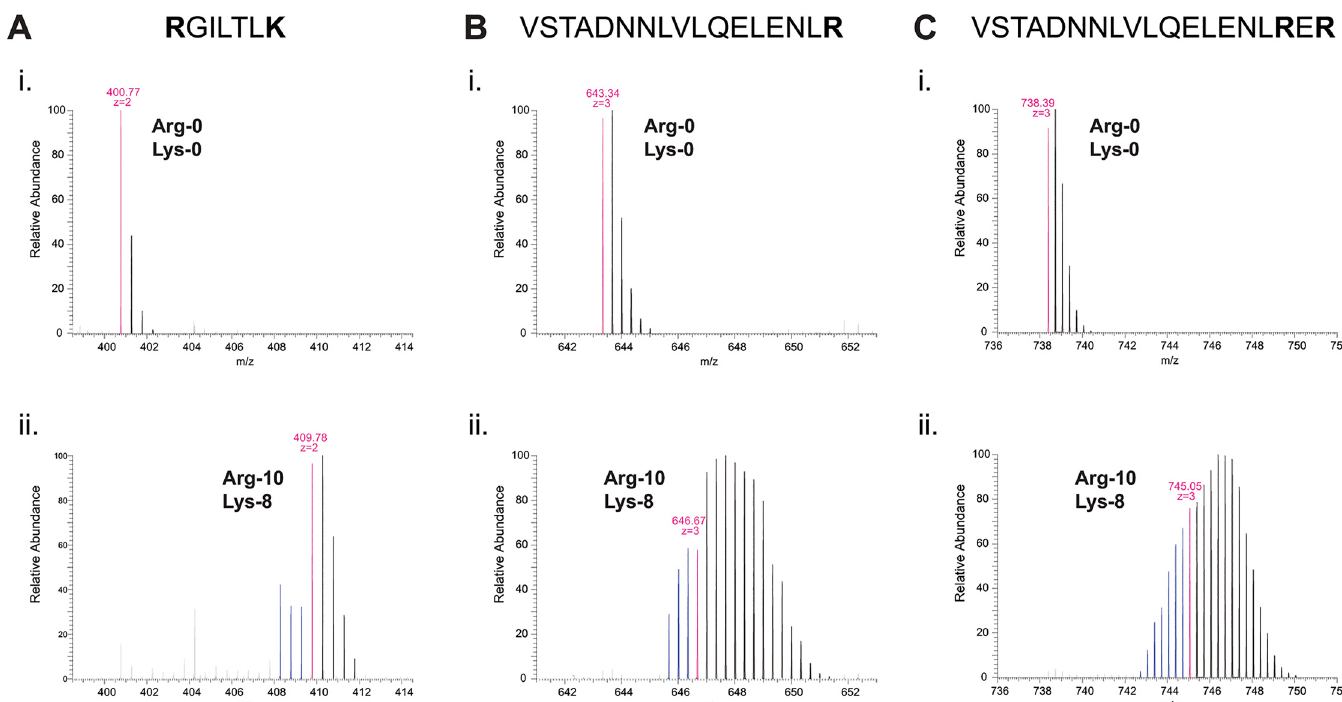
Fig 2. Arginine-containing peptides from cells grown in 13 C 615 N 4 -arginine (Arg-10) exhibit lower-molecular-mass peaks that suggest partial loss of “ heavy ” atoms from a portion of the Arg-10 pool. Mass spectra of tryptic peptides (RGILTLK, VSTADNNLVLQELENLR, and VSTADNNLVLQELENLRER in (A), (B), and (C), respectively) from S . pombe (A) actin and (B, C) Mto2[17A]-GFP, isolated from car2 Δ arg1-230 lys3-37 cells grown in either (i) unlabeled arginine (Arg-0) and unlabeled lysine (Lys-0), or (ii) 13 C 615 N 4 -arginine (Arg-10) and 13 C 615 N 2 -lysine (Lys-8), as indicated. In peptides from cells grown in Arg-10, several “ pre-peaks ” are observed (indicated in blue), with molecular masses significantly lower than the expected monoisotopic masses for Arg-10-labeled peptides. The number of pre-peaks is proportional to the number of arginine residues in the peptide (compare (B) and (C)). Mass-to-charge (m/z) ratios of monoisotopic peaks for each growth condition (i.e., assuming no conversion of labeled arginine) and inferred peptide charge-states are indicated in magenta.